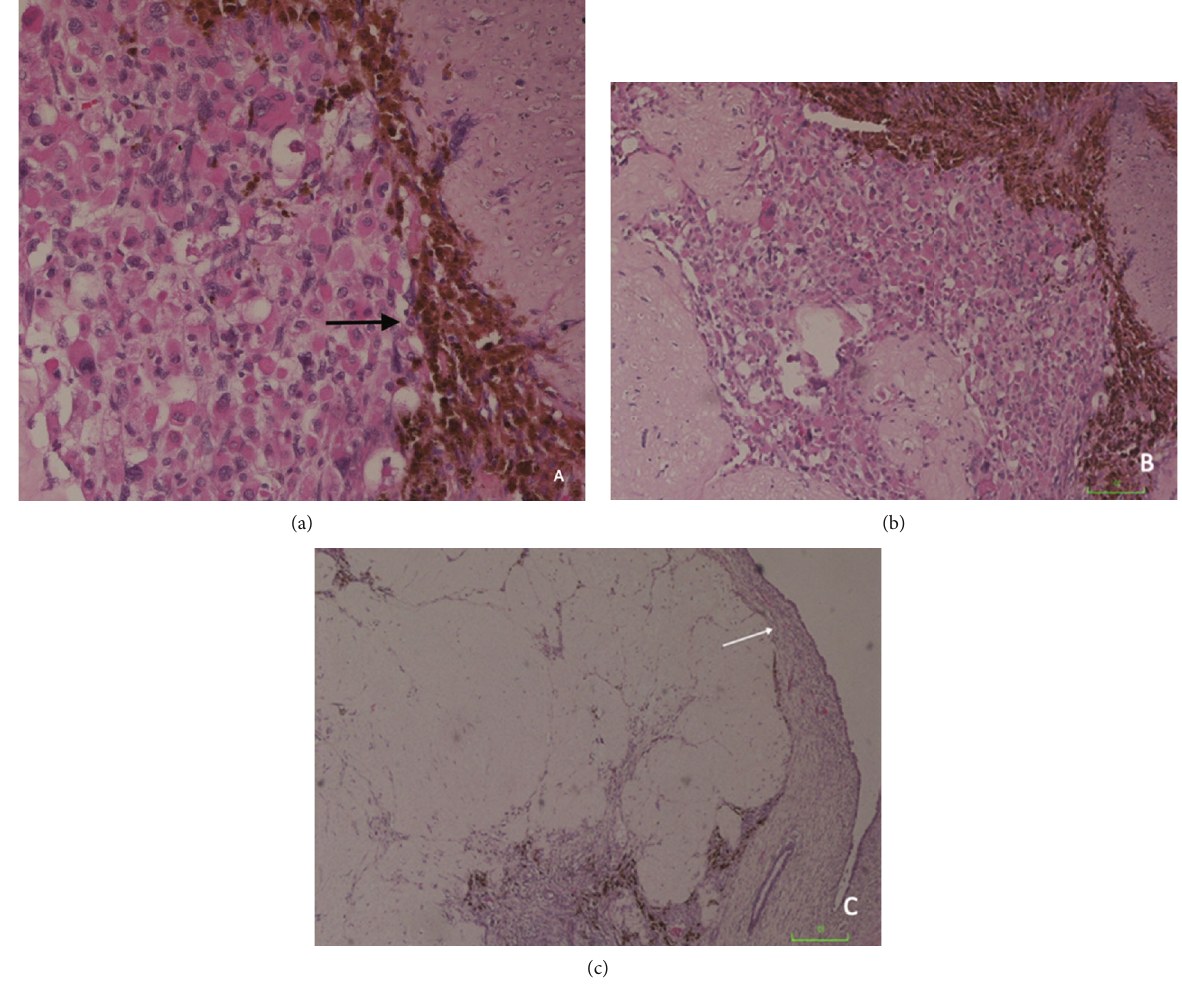
Figure 1: Histopathology and immunohistochemistry of the cervical lesion (a) Tumor cells stain positive for desmin (black arrow). (b) Small, spindled, and round cells interspersed with strap cells against a background of myxoid stroma suggestive of rhabdomyoblastic di ff erentiation. (c) Cambium layer (white arrow) demonstrating foci of subepithelial condensation of undi ff erentiated